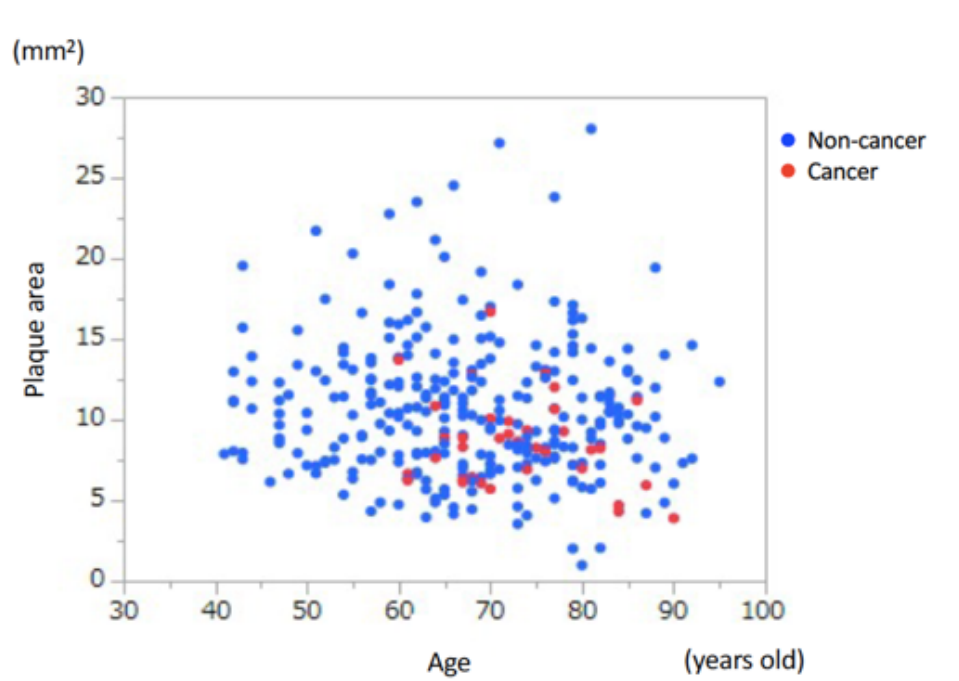
Figure 2. Association between age and coronary atherosclerotic plaque area. There was no significant association between age and coronary plaque area.